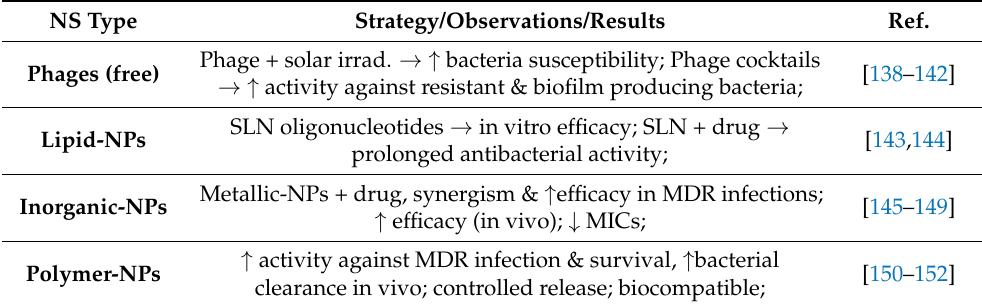
Table 5 summarizes all nanosystems for tretament of CRE infections. Table 5. Nanosystems for treatment of CRE